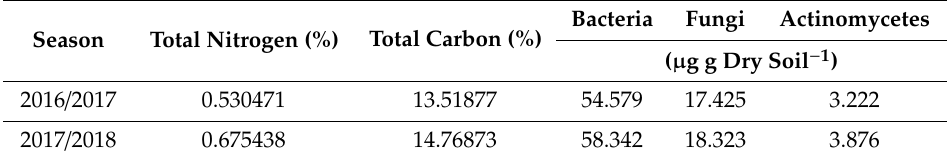
Table 3. Total nitrogen, carbon, and biomass of microbial community of soil used in the two winter growing seasons 2016 / 2017 and 2017 / 2018.